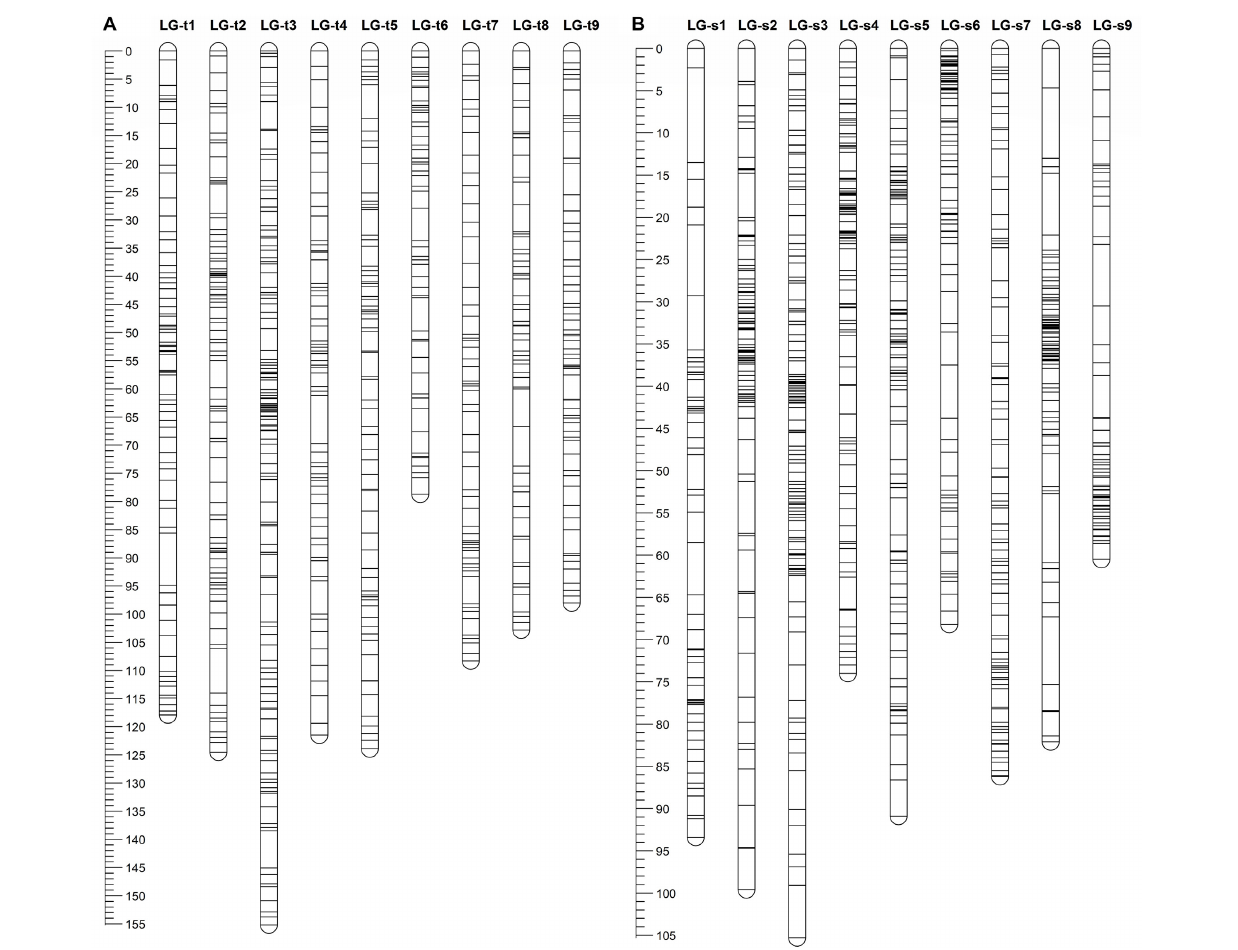
list remained stable. Kruskal–Wallis (KW) test was also